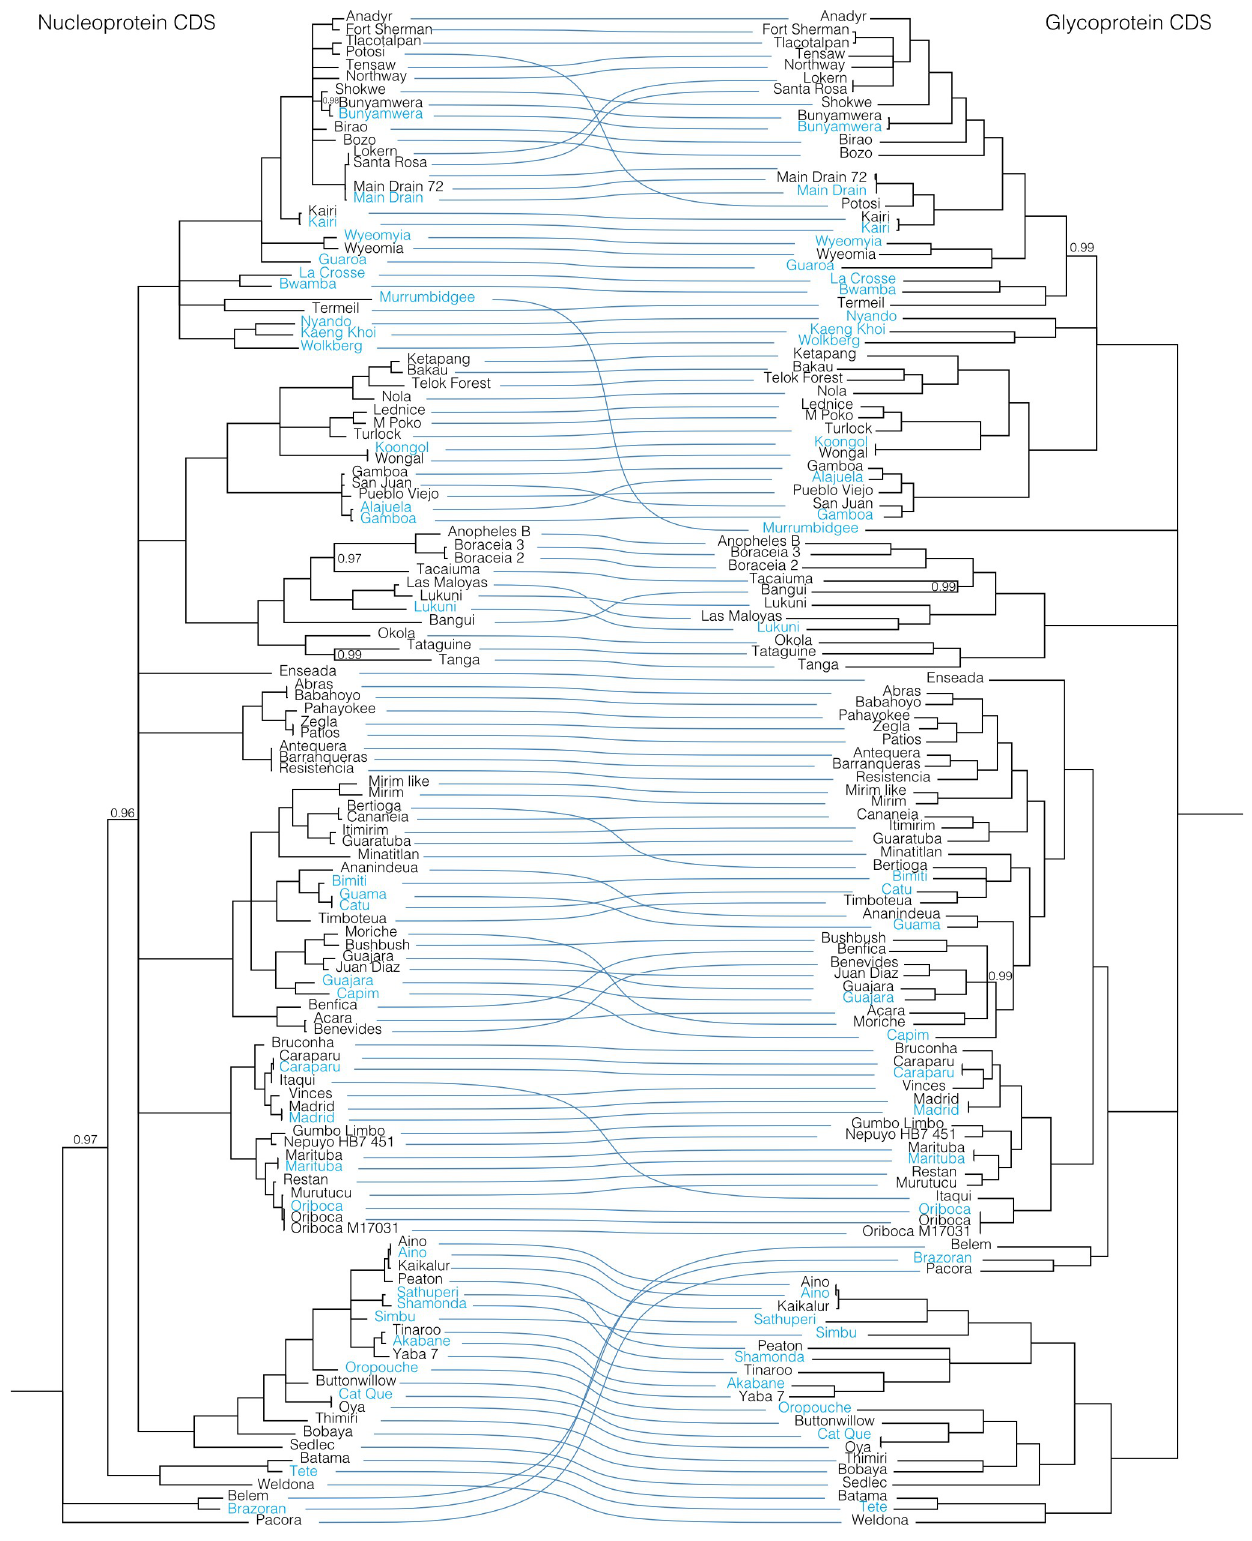
Fig 9. Co-phylogenies of Orthobunyavirus S and M segment trees. Branches with support values < 0.95 were converted to polytomies. All other branch support values were 1 unless indicated. Trees were rooted with outgroups as in Figs 2–4.